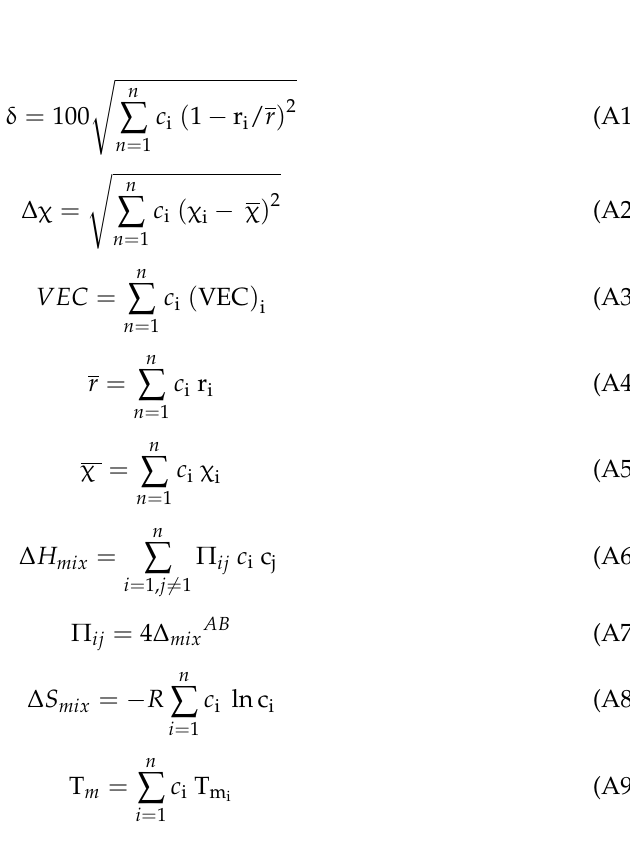
Figure S2: X-ray diffractograms of oxide scale formed on the alloy TT2 (a) at 800 ◦ C and (b) at 1200 ◦